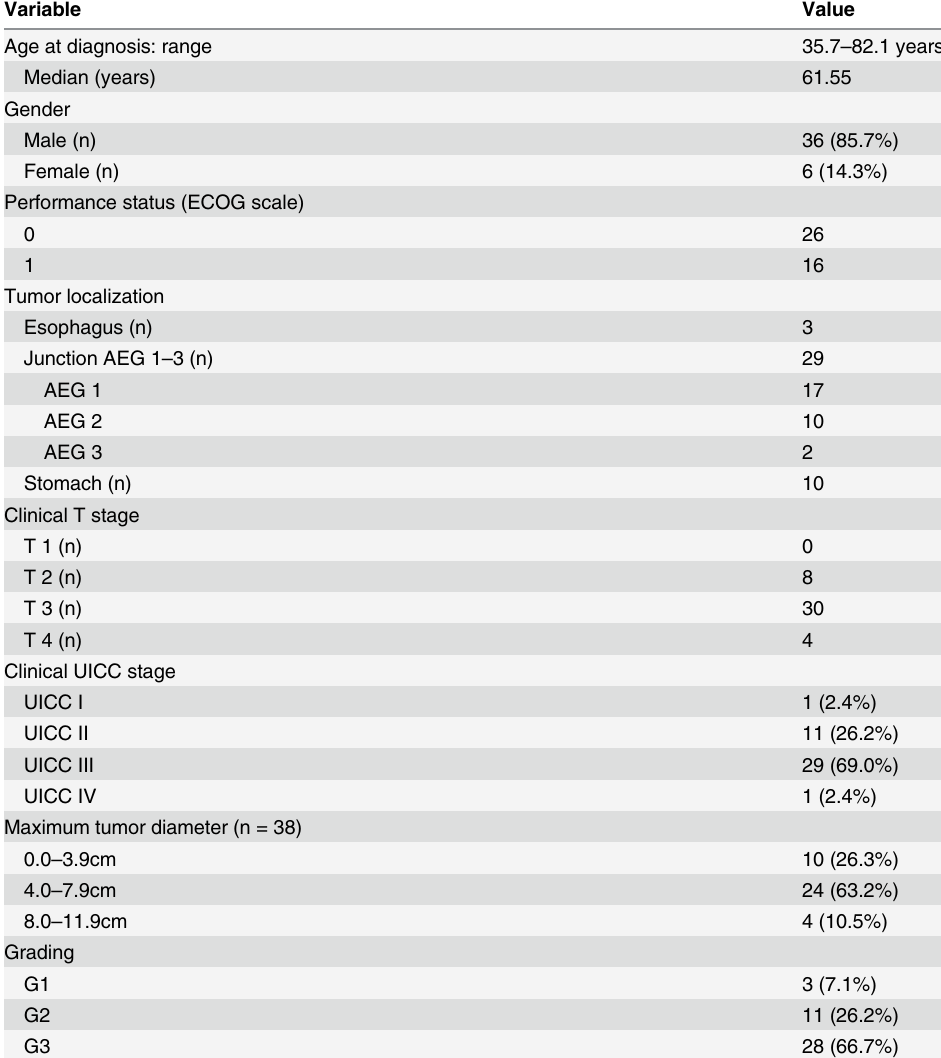
Table 1. Pretherapeutical patient ’ s and tumor characteristics, and tumor